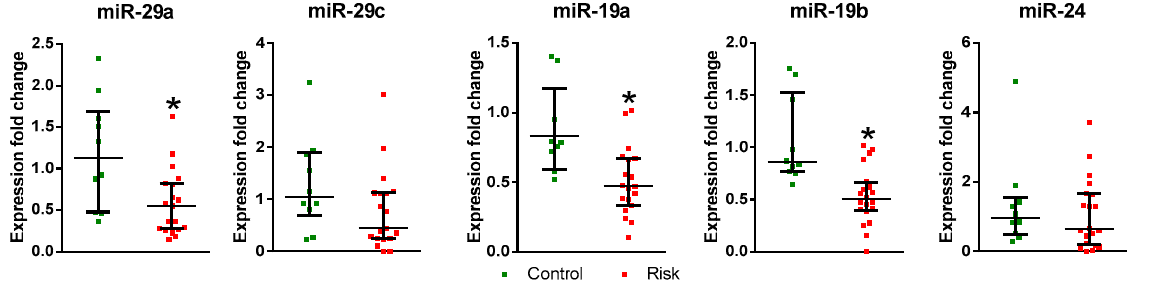
Figure 4. Expressions of miR-29a, miR-29c, miR-19a, miR-19b, and miR-24 in the plasma of patients at risk of developing Parkinson’s disease and in the controls. * p < 0.05, statistically significant differences. Data presented as a median with an interquartile range and min–max values.